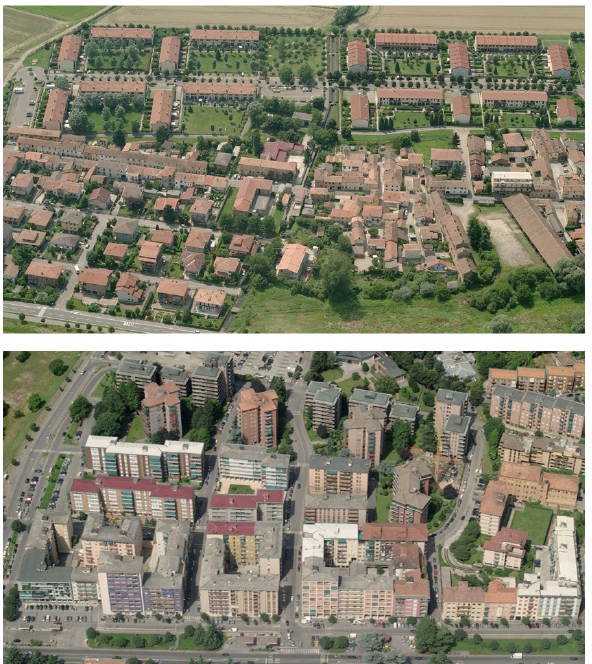
Figure 8. Bird’s eye images of two areas of the municipality of Pavia with different predominant building typologies. Top: GC1, mainly low-rise buildings; bottom: GC2, mainly high-rise build- ings. Source: Bing Maps.